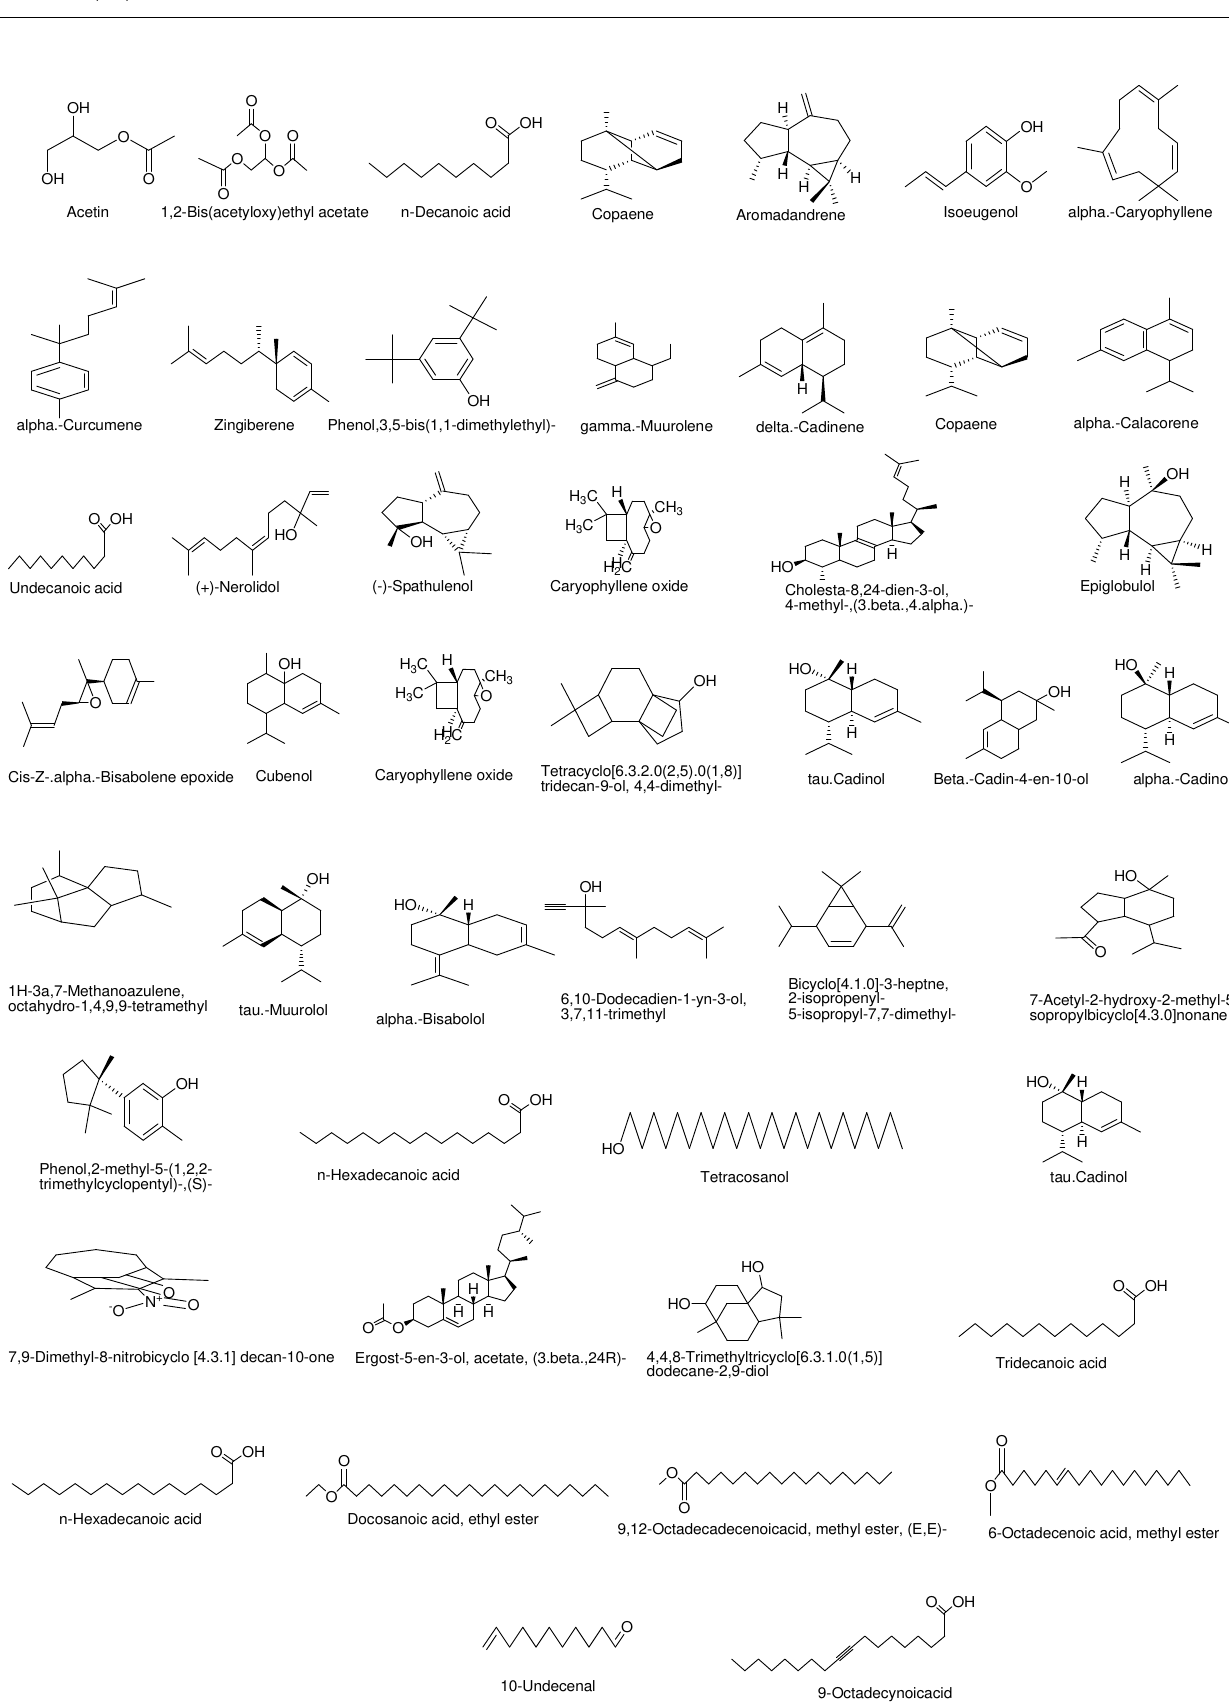
Figure 1. Structures of identified compound of ethyl acetate fractions.